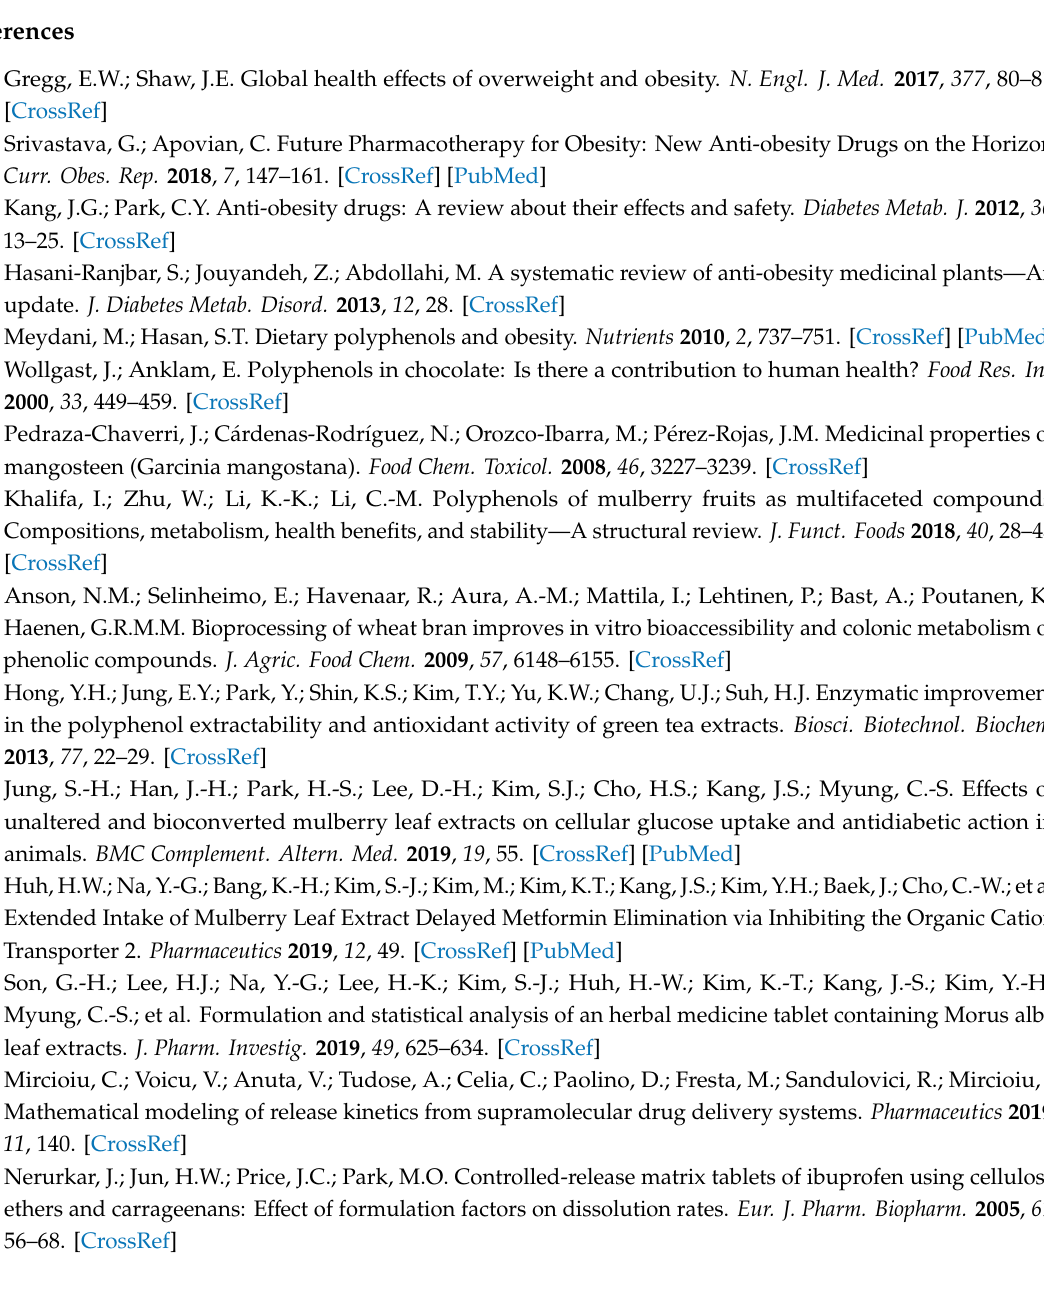
Table S1: Analysis of variance for model of GA %dissolved at 2 h (Y 1 ), Table S2: Analysis of variance for model of GA %dissolved at 6 h (Y 2 ), Table S3: Analysis of variance for model of GA %dissolved at 12 h (Y 3 ), Table S4: Analysis of variance for model of BMUL %dissolved at 2 h (Y 4 ), Table S5: Analysis of variance for model of BMUL %dissolved at 6 h (Y 5 ), Table S6: Analysis of variance for model of BMUL %dissolved at 12 h (Y 6 ), Table S7: Analysis of variance for model of hardness (Y 7 ), Table S8: Analysis of variance for model of friability (Y 8